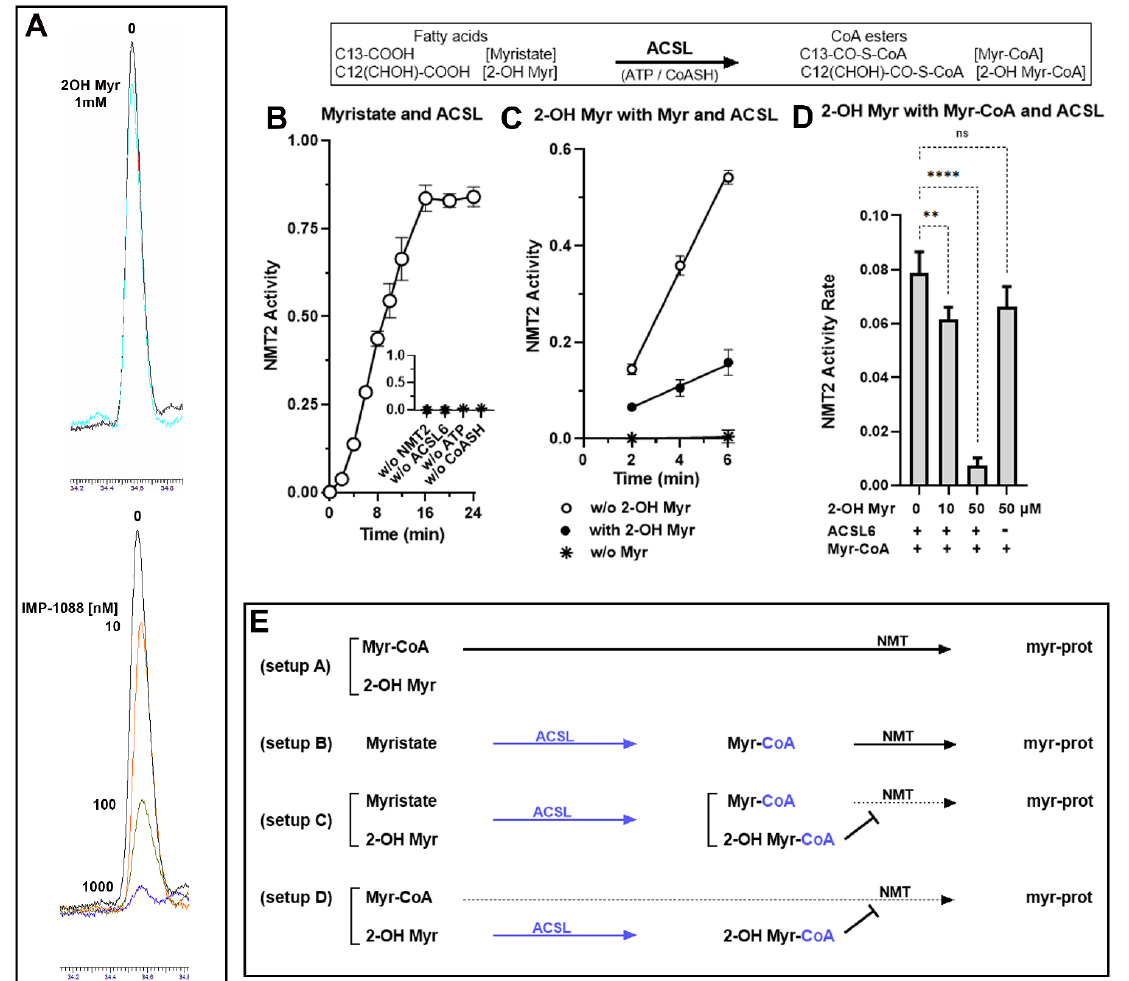
Figure 1. Thioesterification requirements for acyl- donors and competitors’ formation . ( A ) Meas- urements of the formation of the myristoyl-peptide were performed in the absence or presence of the drug IMP-1088 (10 – 100-1000 nM) or the fatty acid analog 2-OH Myr (1 mM). Reactions were performed with 250 nM NMT2 enzyme in the presence of 50 µM Myr-CoA and the indicated con- centration of drugs for 20 min at 37 °C. The peptide and myristoyl-peptide were extracted and quan- tified by HPLC on a C18 column, as previously described [2]. The chromatogram traces obtained at 274 nm at the time of the elution of the myr- peptide (≈34. 6 min) from the C18 column were over- lapped, as indicated. ( B ). Measurements of the formation of the myristoyl-peptide were performed in the absence of the NMT substrate Myr-CoA but in the presence of the myristate precursor Myr and human acyl-CoA synthetase ACSL6 enzyme. Reactions were performed from 0 to 24 min with NMT2 (250 nM), Myr (20 µM) and ACLS6 (150 nM) in the presence of ATP and CoASH. Inset: Con- trol reactions were performed in the absence of either NMT2, ACSL6, ATP or CoASH, Formation of the myr-peptide was quantified after 24 min incubation. ( C ). Measurements were performed as de- scribed in panel B but in the absence (open circle) or the presence of the fatty acid analog 2-OH Myr (100 µM) (filled circle). Control reactions were performed in the absence of the acyl-donor precursor Myr (asterisk). ( D ). Measurements were performed as described in panel C, but myristate was re- placed by Myr-CoA (10 µM). The rates of myr-peptide formation were calculated and are presented as the amounts of myristoyl-peptide formed per min. Reactions were performed with the indicated concentration of 2-OH Myr in the absence or presence of ACSL6. Error bars in ( B – D ) represent the standard deviations of values obtained from at least three reactions: n.s., non-significant; **, p = 0.01; ****, p < 0.0001. A cartoon representation of the fatty acids and of their CoA ester derivatives